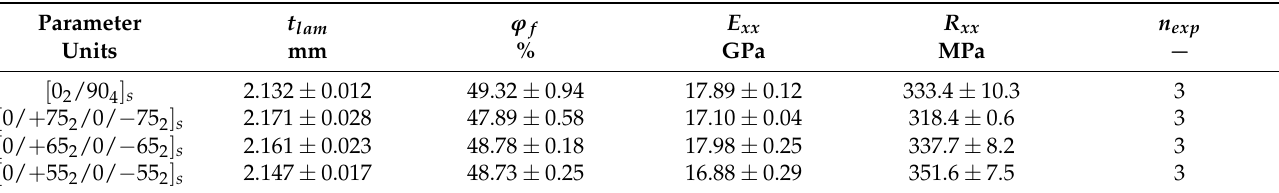
Table 2. Properties of GFRP laminates with multiaxial